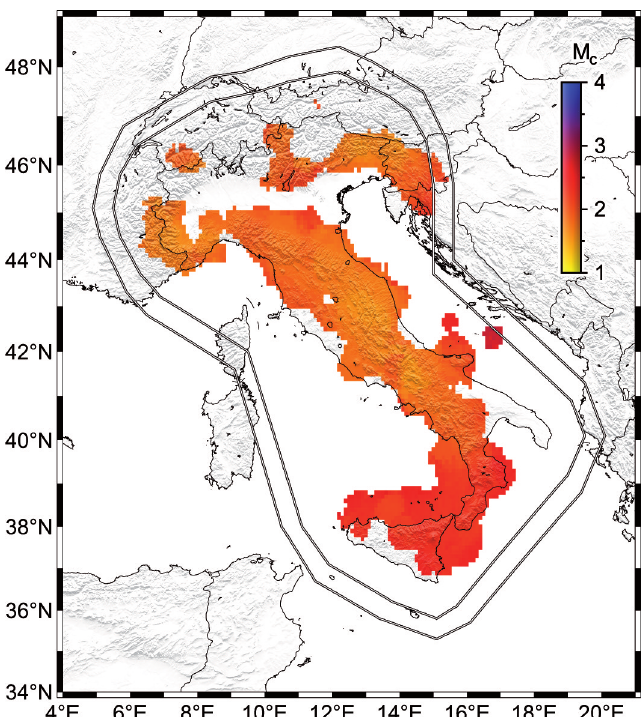
Figure 5. Map of completeness magnitude, M , of the CSI 1.1 computed c using the Maximum Curvature method with sampling radii of 30 km. Nodes with less than 30 sampled earthquakes above the computed completeness level are left blank. The inner and outer polygons mark the extent of the testing area and collection area,